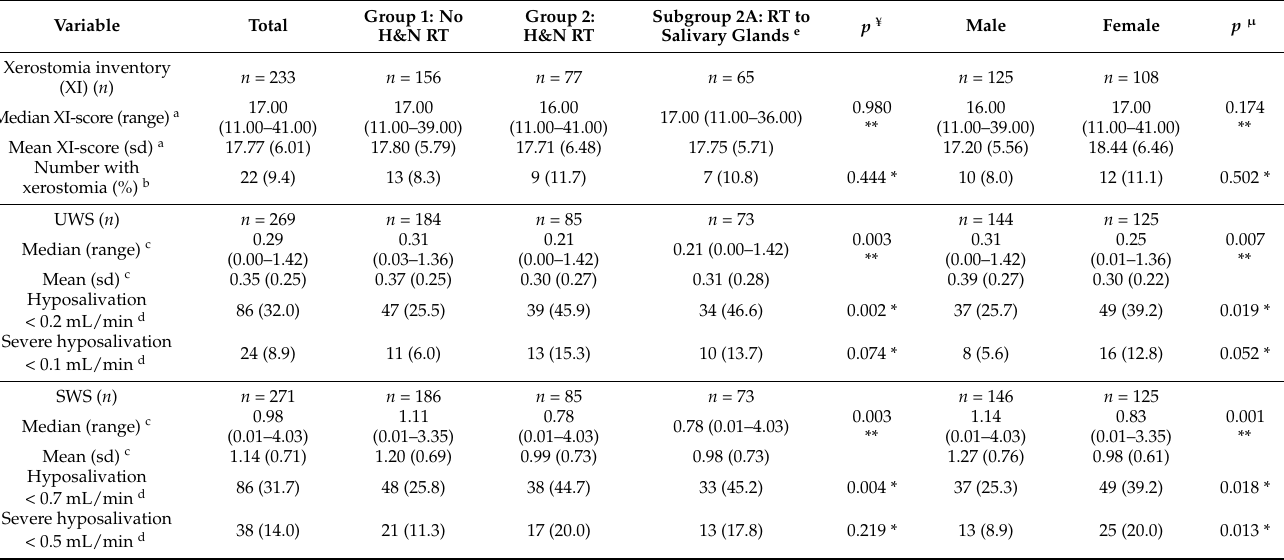
Table 3. Prevalence of xerostomia, unstimulated and stimulated salivary flow rate, stratified according to the type of treatment and gender in childhood cancer survivors.